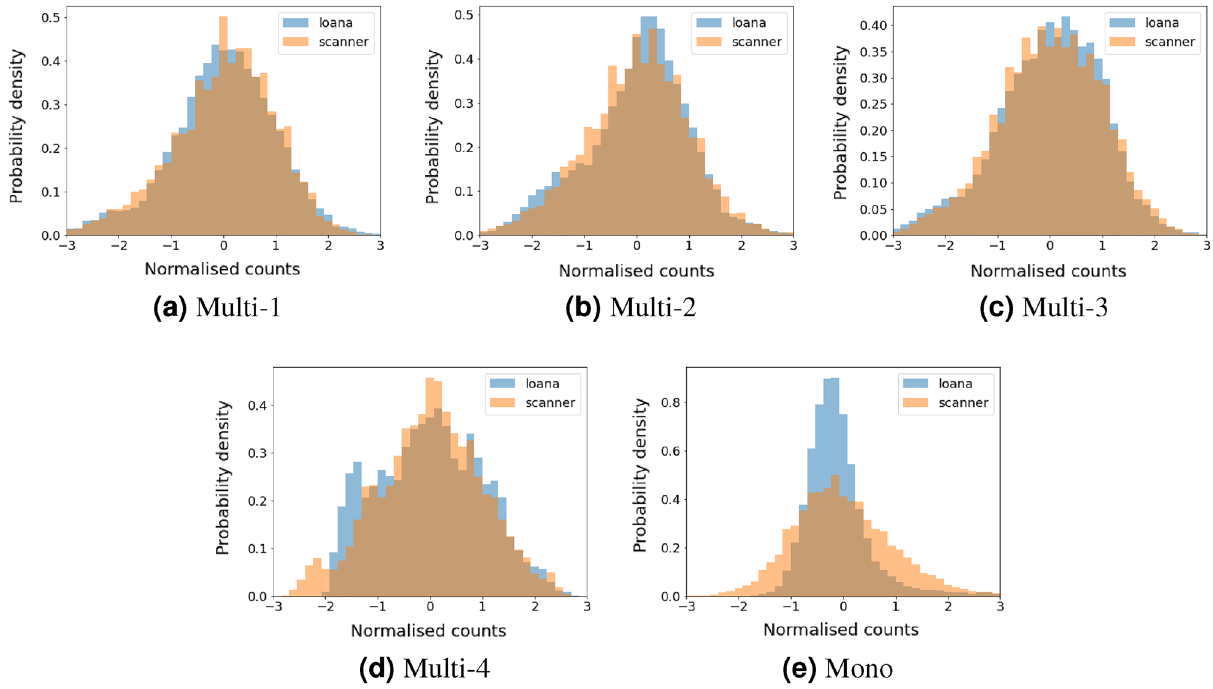
Figure 4. Normalised frequency histograms of the signal received on the samples from both the LOANA and CIS based scanner. Samples are shown in the same order as Fig. 3.